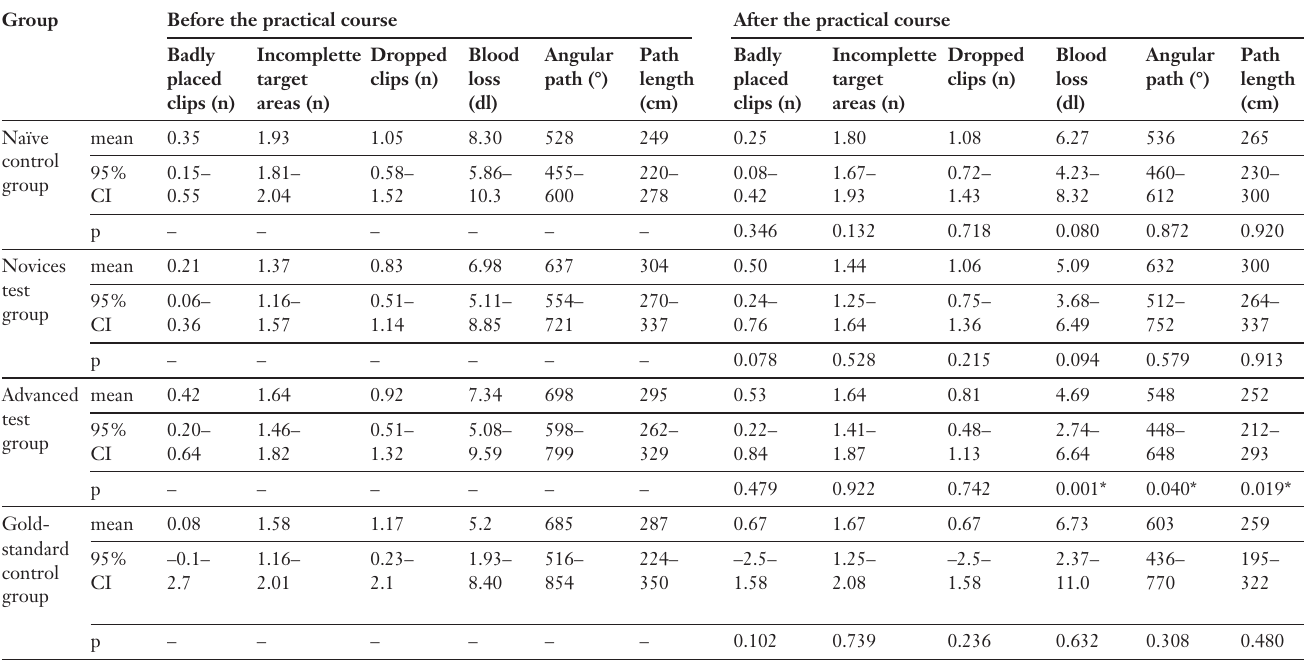
Means and 95% confidence intervals (95% CI) of the performance parameters of the test and control